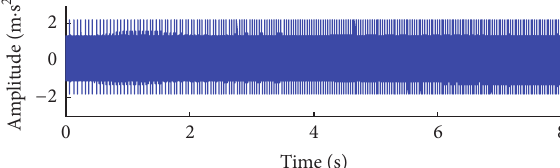
Figure 4: The waveform of the simulated vibration signal without